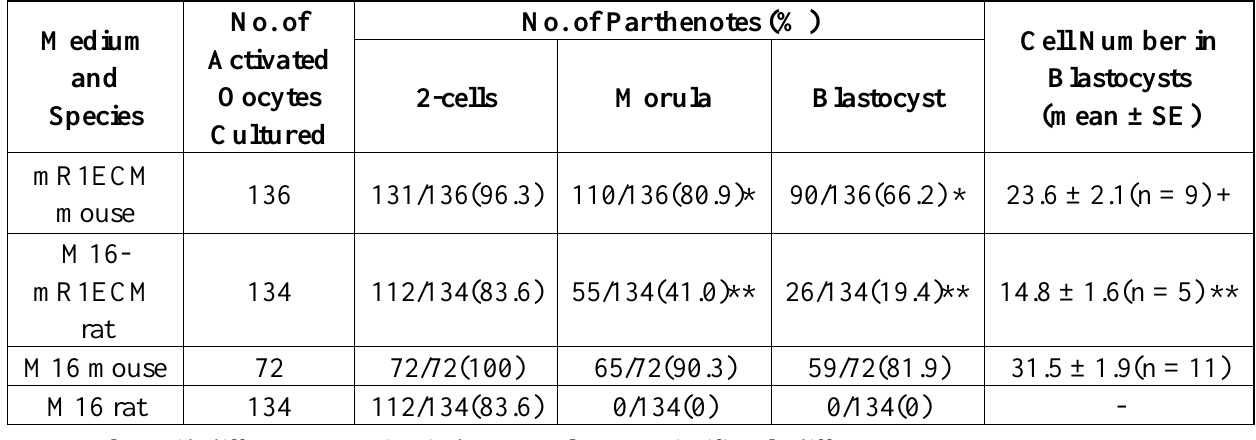
Table 1 . Effect of culture medium on in vitro development of mouse and rat parthenogenetically activated oocytes.